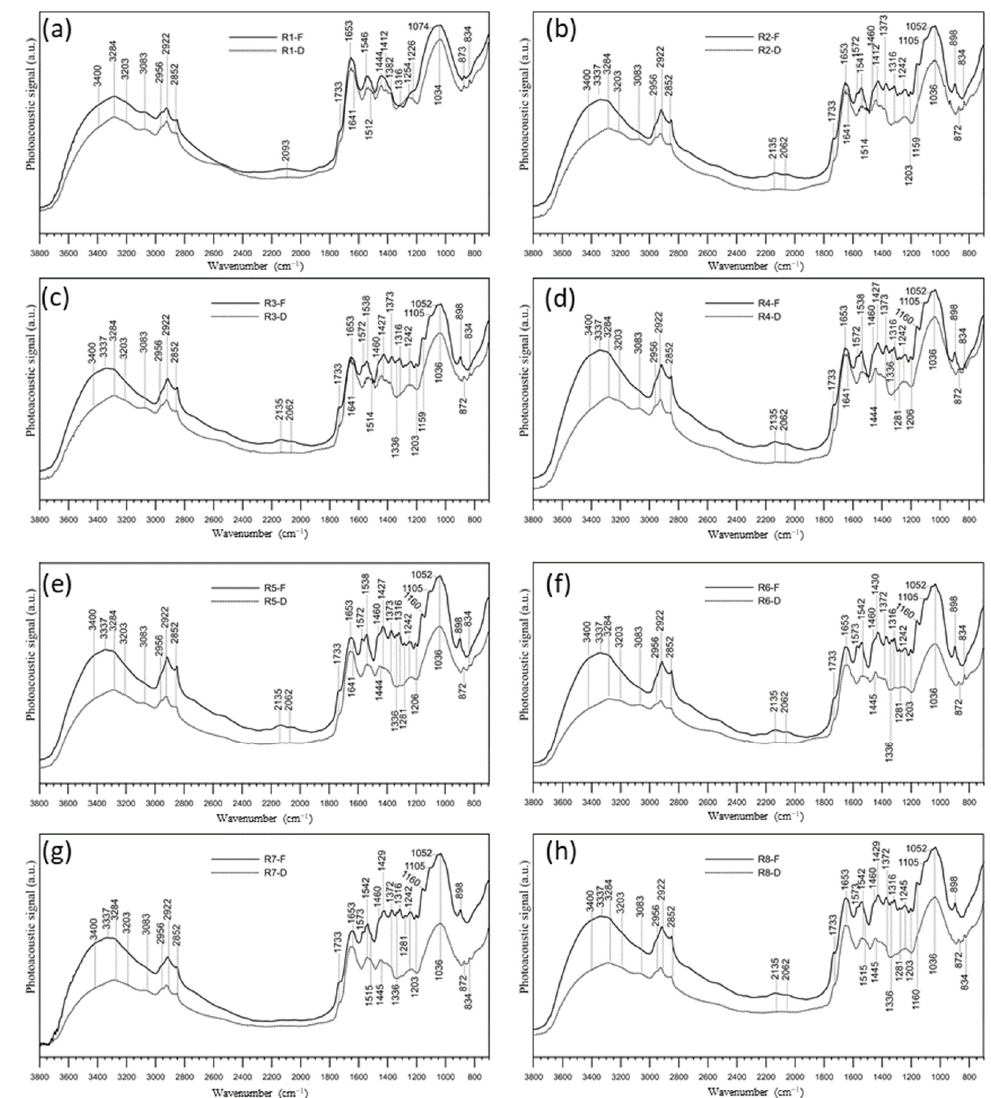
Figure 3. FT-IR/PAS spectra before (F) and after digestion (D) in the series ( a ) R1, ( b ) R2, ( c ) R3, ( d ) R4, ( e ) R5, ( f ) R6, ( g ) R7, ( h ) R8.